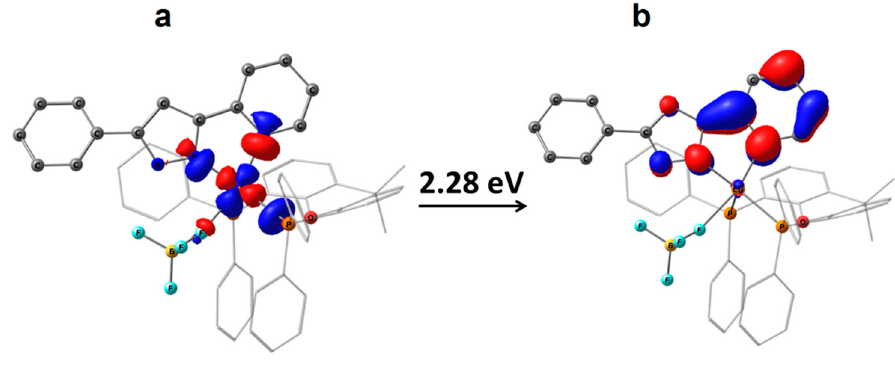
Figure 6. LSOMO ( a ) and HSOMO ( b ) contours for restricted open-shell triplet state T pyr of 2 as isosurface at 0.05 a.u.